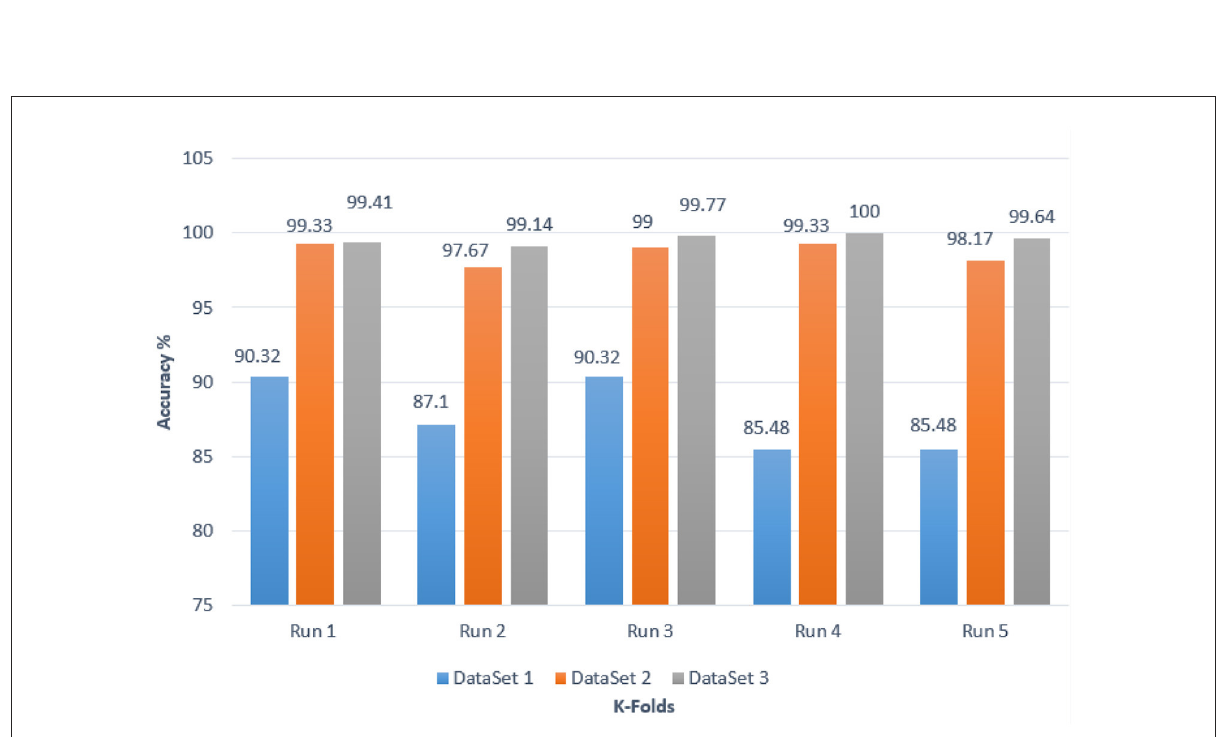
FIGURE7 Accuracy values for different k -folds using the BRAIN-TUMOR-net with stratified k -fold validation on the three MRI brain tumor datasets.